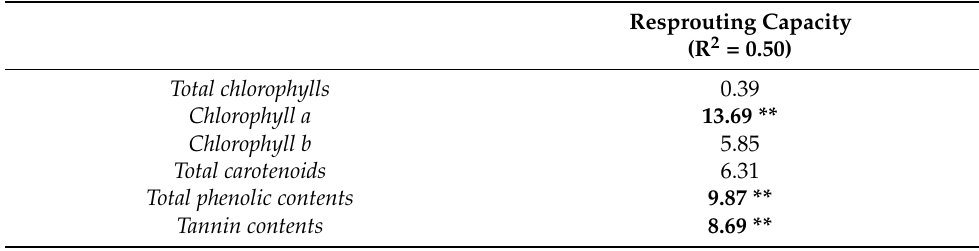
Table 5. Effects of photosynthetic compounds and secondary metabolites over resprouting capacity in five native woody species from the Chaco Region. Values indicate the F-values of the backward regression between bioactive compounds and RC; stars indicate the significance level. Significance levels: ** <0.01;